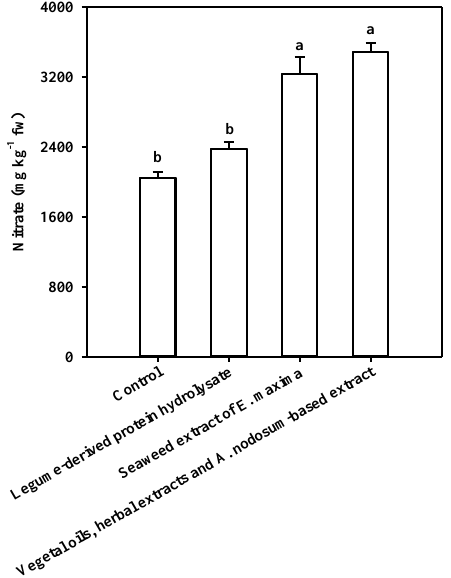
Figure 2. The effect of biostimulant treatments on leaf nitrate content of greenhouse spinach plants. The values are means of three replicates. Vertical bars indicate ± SE of means. Different letters indicate significant differences according to Duncan’s test ( p < 0.05).